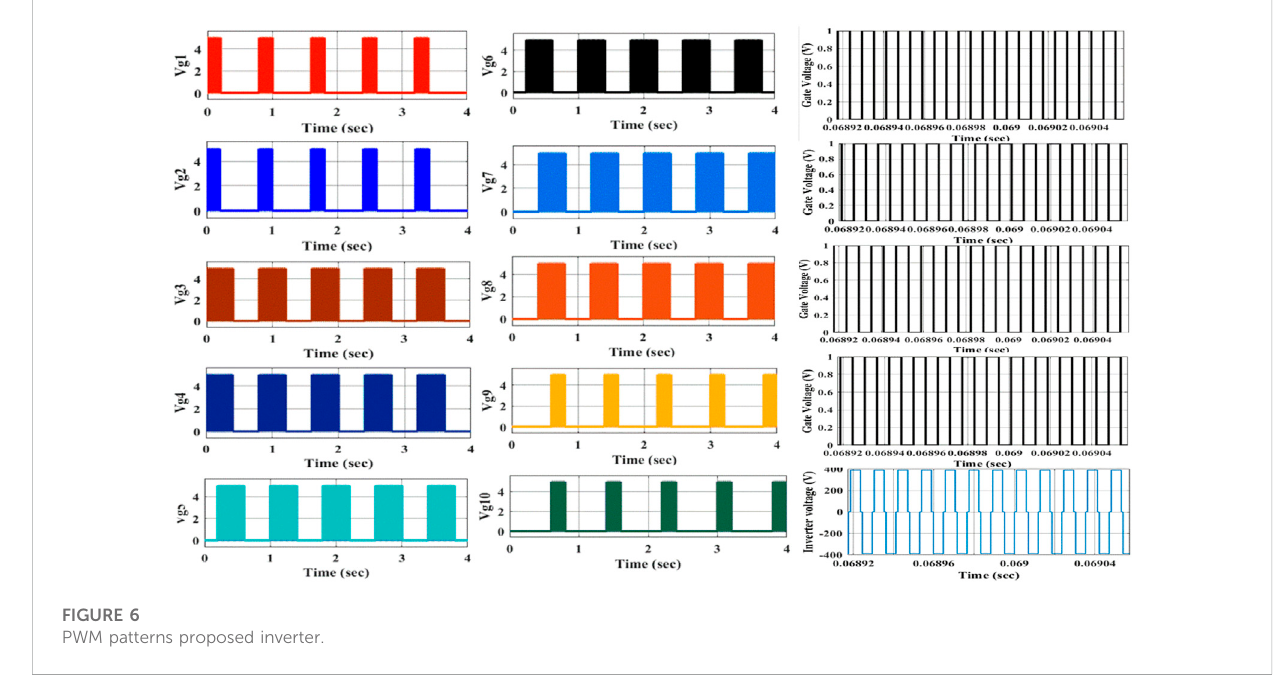
FIGURE 6 PWM patterns proposed inverter.